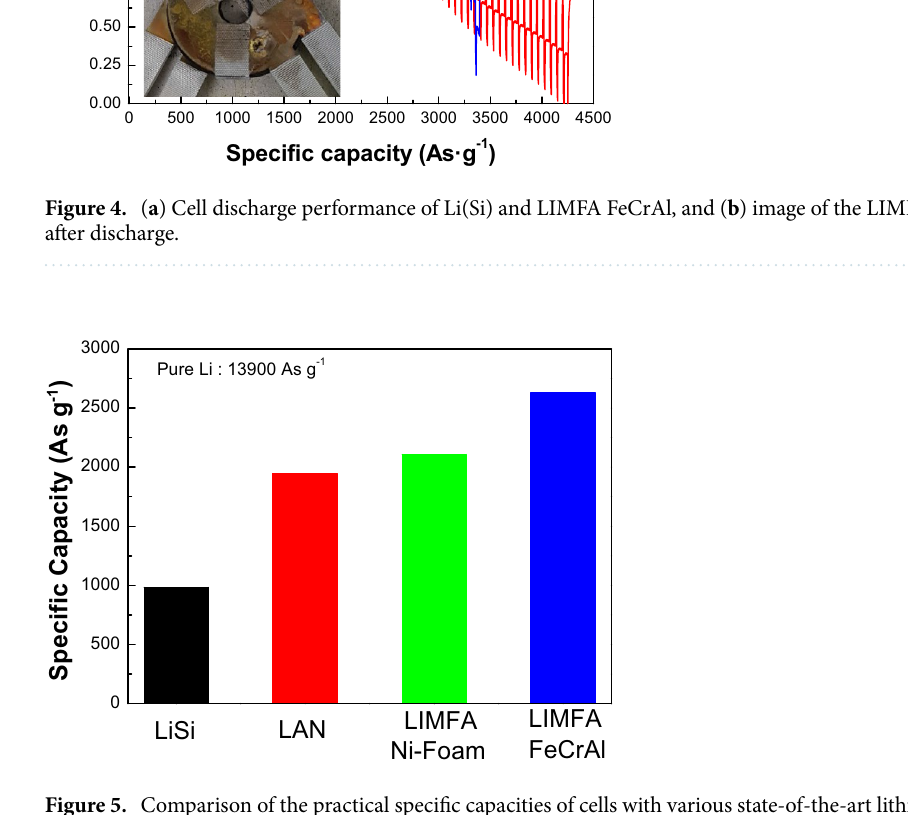
Figure 5. Comparison of the practical specific capacities of cells with various state-of-the-art lithium anodes with that of LIMFA FeCrAl in this study.